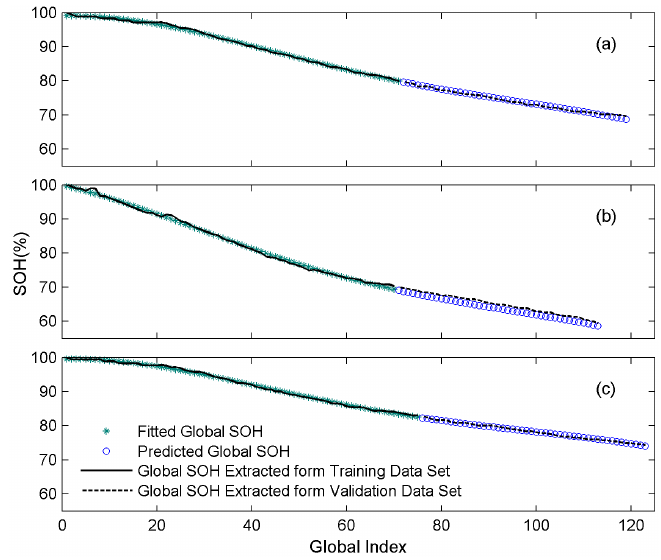
Figure 8. Prediction results of global degradation: ( a ) battery No. 5; ( b ) battery No. 6; and ( c ) battery No. 7.